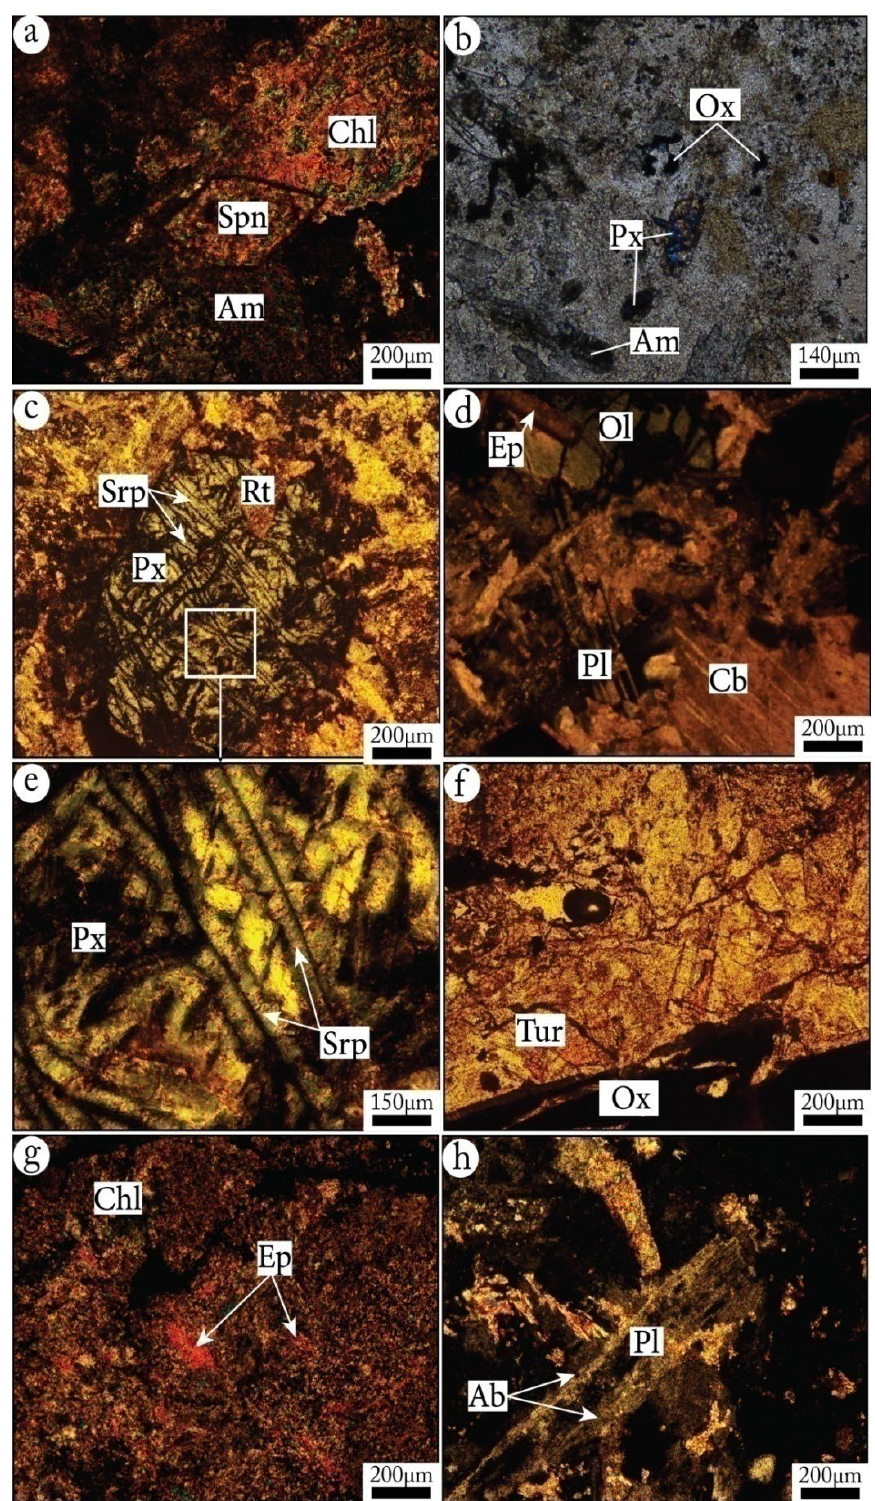
Figure 17. ( a – h ) Microphotographs of the alteration phases of olivine-bearing gabbros: sericitized (Ser) and albitized (Ab) plagioclase (Pl), amphibolitized (Am) and epidotized (Ep) pyroxene (Px), serpentinized (Srp) and chloritized (Chl) olivine (Ol), tourmaline (Tur), and oxides (Ox) (transmitted light—crossed nicols).